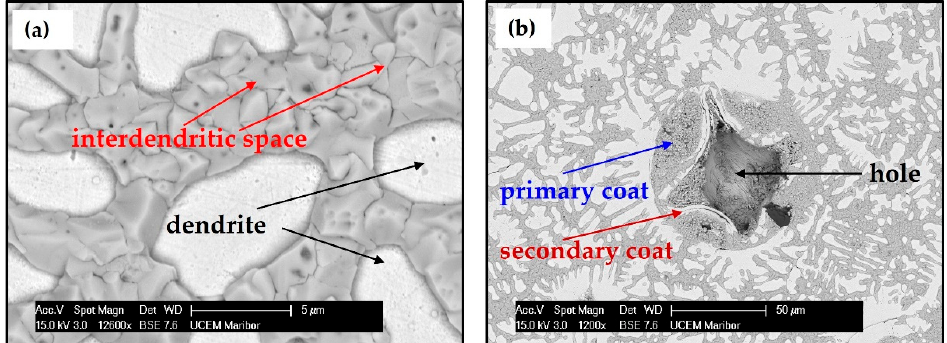
Figure 4. Annealed (900 °C for 336 h) CCNA microstructure ( a ) Dendrites and interdendritic space of the matrix ( b ) A hole with coats.